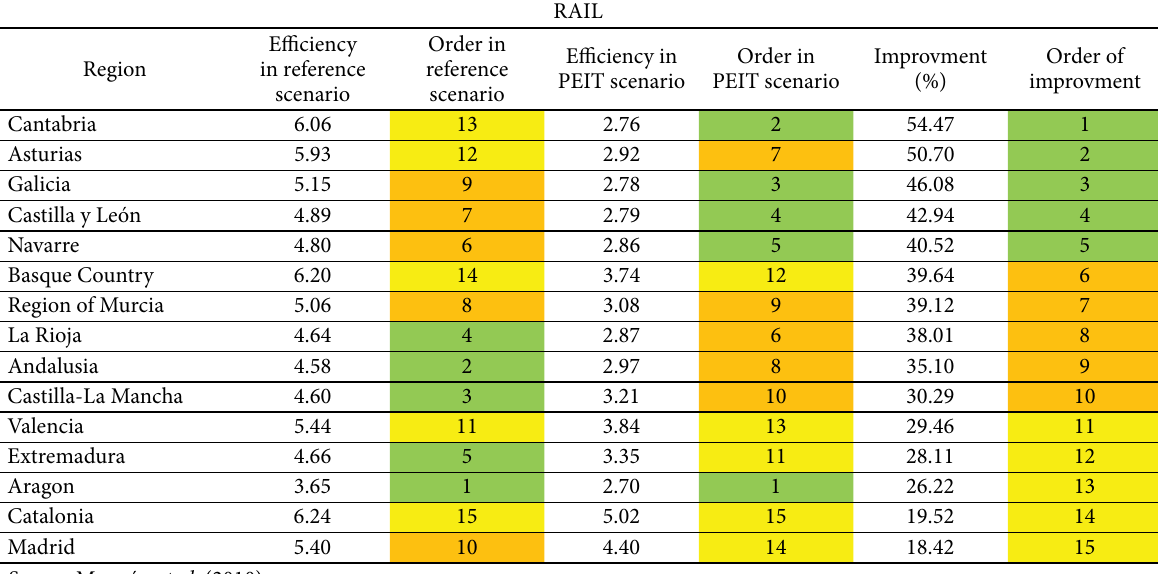
Table 5. Values and variation of accessibility by rail for different autonomous regions